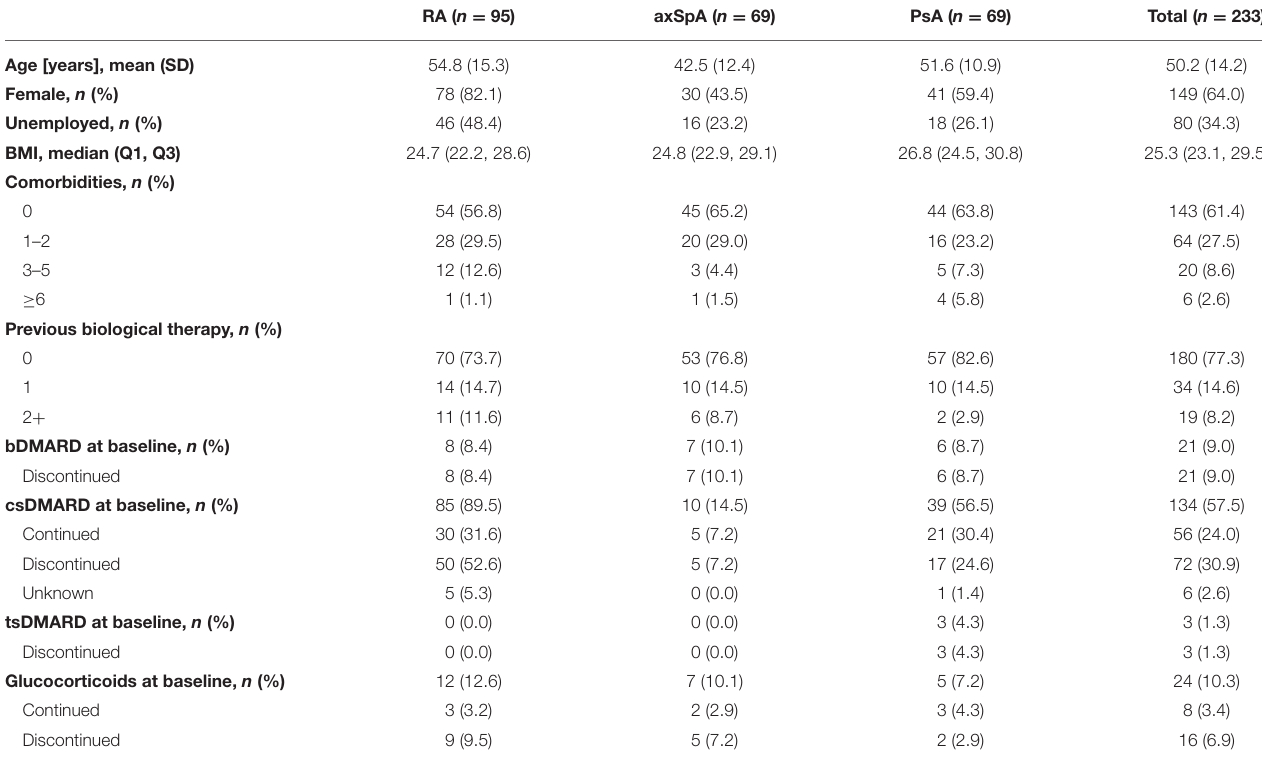
TABLE 1 | Patient characteristics at